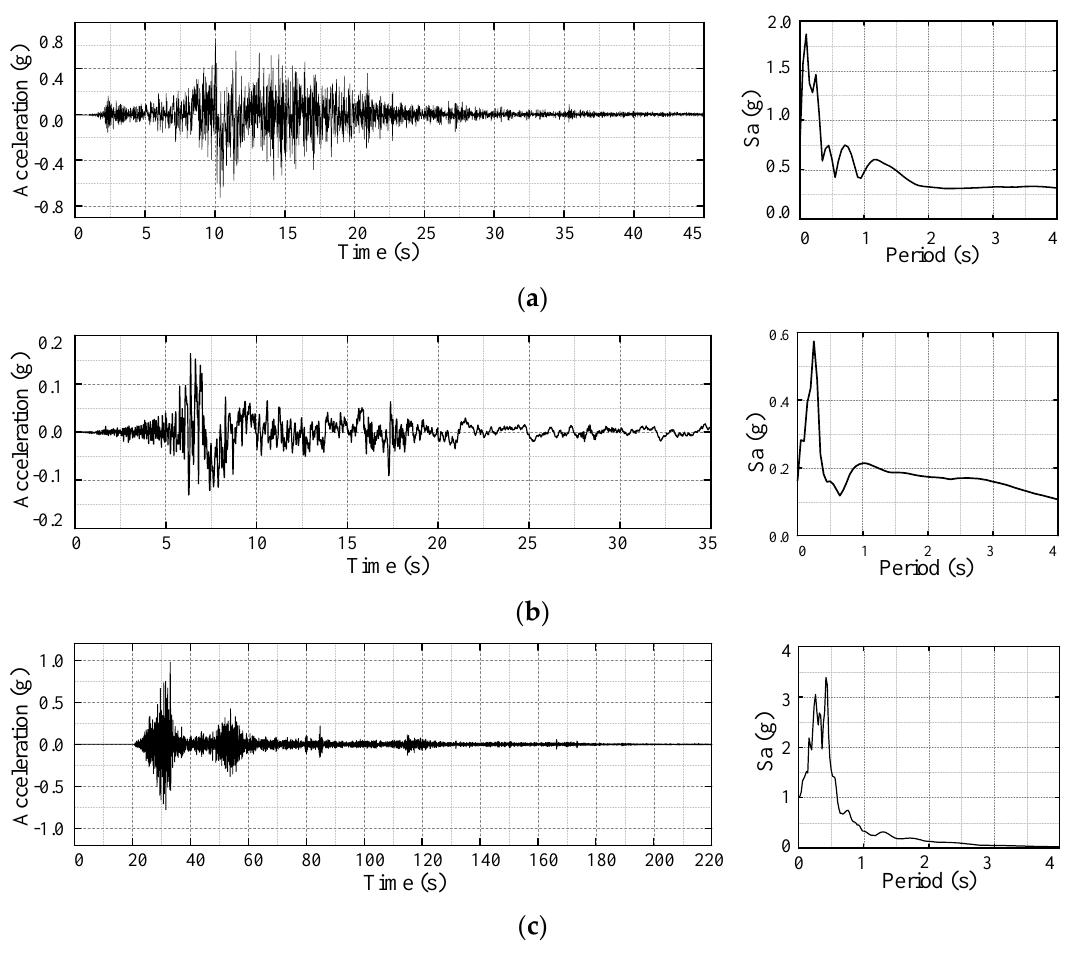
Figure 8. Acceleration time history and spectral acceleration of the input motions. ( a ) Lander ground motion [27], ( b ) Imperial Valley ground motion [28], ( c ) Wolong ground motion [29].